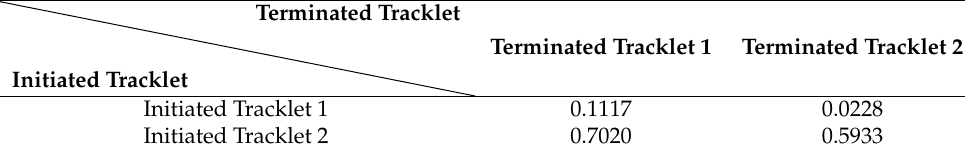
Table 2. Association costs between different tracklet combinations of target 1 and target